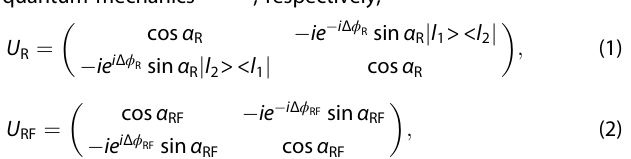
j iÞ þ e i ϕ 0 #j ið l 2